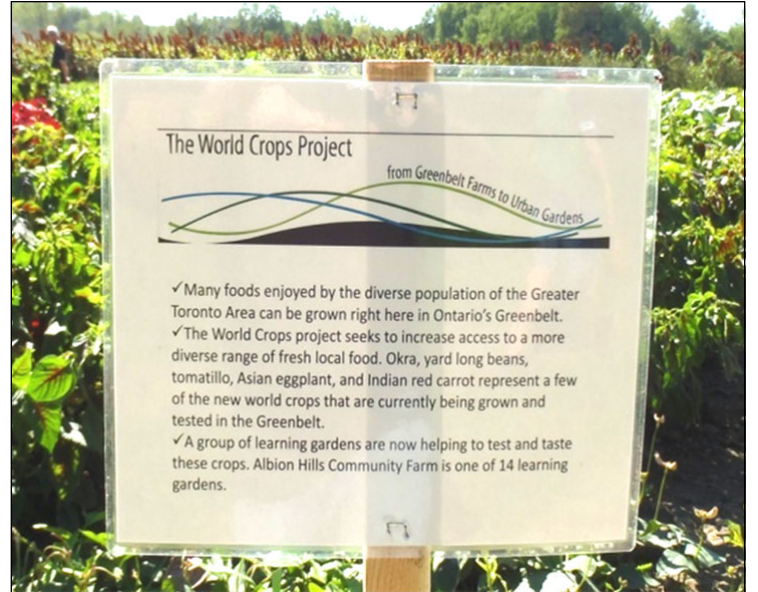
Photo source: Robert